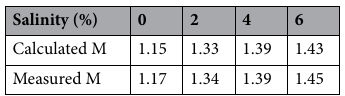
The M values of soil at different salinities were calculated by the above equation and compared with the measured M value shown in Table 5. It was found that the calculated values are highly approximate to the meas- ured ones, suggesting the M value of soft saline clay in this study is a function of effective internal friction angle; thus, the CSL of soft marine clay at different salinities could be predicted by the effective internal friction angle. The undrained shear strength S u from the consolidated undrained triaxial test was plotted with the mean effective stress p ′ , as shown in Fig. 7a. The S u was taken as half of the maximum deviator stress ( q max / 2 ) in the case where the peak value was observed before reaching 15% axial strain, or half of the deviator stress at the axial strain of 15% in the case where no peak value was exhibited. The undrained shear strength increases with increasing mean effective stress for soil at all salinities, which fits the results of remolded clay presented by Yin et al. 47 . However, the increasing rate of undrained shear strength was different for soils at different salinities, where S u of high salinity is higher than that of lower salinity under a given mean effective stress. It suggests that the porewater salinity would significantly affect the undrained shear strength of soft marine clay. Figure 7b shows the undrained shear strength versus porewater salinity under different mean effective stress. The undrained shear strength has an overall increasing trend with porewater salinity regardless of mean effective stress. Under low consolidation pressure (50 kPa), the increase in strength was relatively small (e.g., 3 kPa with the soil specimen of salinity from 0% NaCl to 6% NaCl); whereas the strength was significantly increased under high consolida- tion pressure (200 kPa), where S u increased 30% from 61 to 79 kPa with the soil of salinity from 0 to 6%. It could attribute to the increased internal friction angle as large soil aggregates were formed. And the increasing rate in undrained shear strength was slowed as the porewater salinity kept increasing, where the aggregated and floc- culated associations between soil particles were no longer evident (Fig. 4). Figure 8 shows the relationship between undrained shear strength and the post-consolidation water content of soil specimens at different porewater salinities. The water content remained constant during shear and was of the same value as after consolidation since the test was conducted in undrained conditions. The undrained shear strength decreases as the water content increases regardless of porewater salinity, where the water content after shear was closely related to the initial water content of the soil. The undrained shear strength behavior can be explained in that the initial water content was low as the liquid limit of soil was reduced due to the effect of salt, in which condition the measured water content would be low after consolidation under a given confining pressure. Therefore, high undrained shear strength of soil was observed. Hong et al. 48 summarized the unconsolidated undrained shear strength of 115 remolded clays with a liquid limit lower than 150% all over the world and proposed a relationship between undrained shear strength and the normalized water content by a well-fitted empirically equation as expressed in Eq. (6). − 4.5 (6) C ur = 1.4 × ( w ′ ) where C ur is the undrained shear strength of remolded clay, and w ′ is the normalized water content, defined as the ratio of natural water content ( w ) to the liquid limit (LL) of soil. Yin et al. 47 normalized the water content